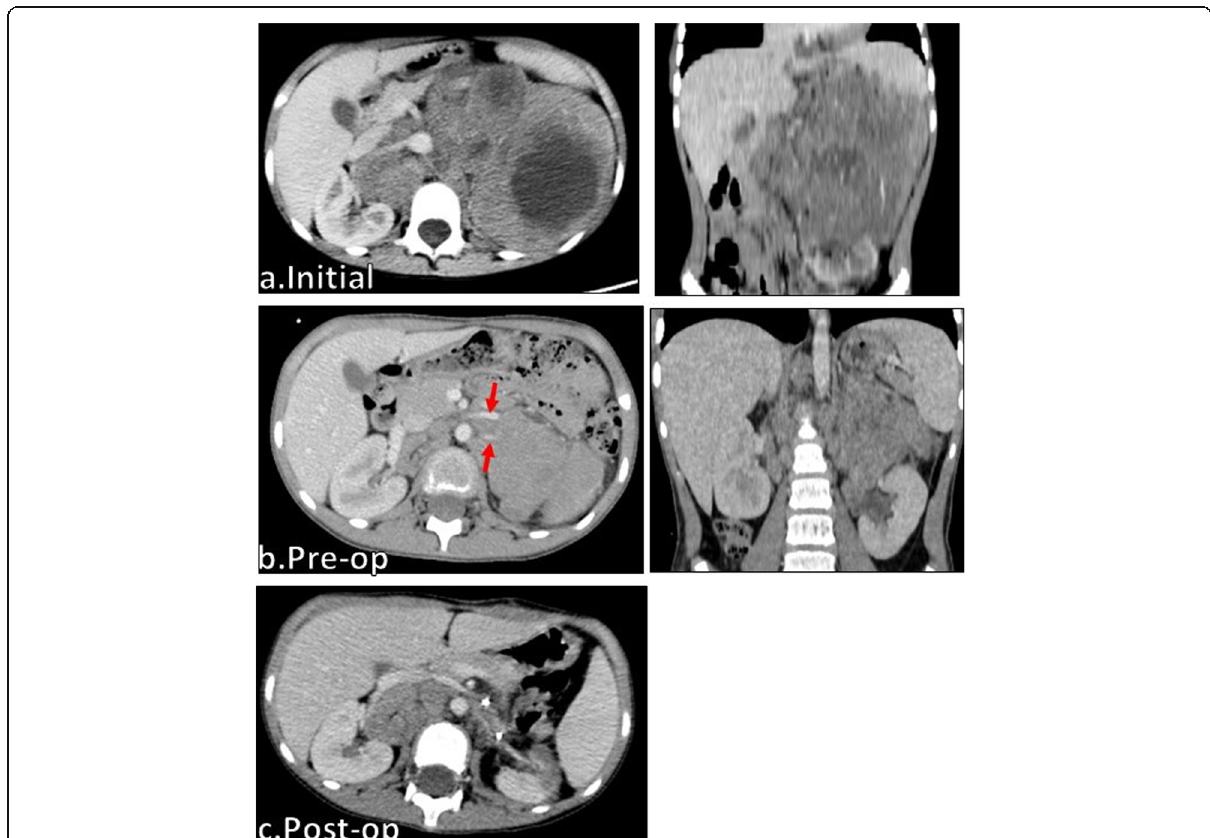
Fig. 9 A 7-year and 9-month-old female. a Initial CT axial and coronal cuts showing abdominal neuroblastoma lesion encasing the aorta, SMA, renal pedicles, and infiltrating the left kidney. b Pre-operative CT axial and coronal cuts show regressive course regarding the size of the lesion with disappearance of most of the IDRFs except for the encasement of the left renal vessels (red arrows). c Post-operative CT axial cut showing small sized left kidney with renal infarcts, with progression of the residual retrocaval